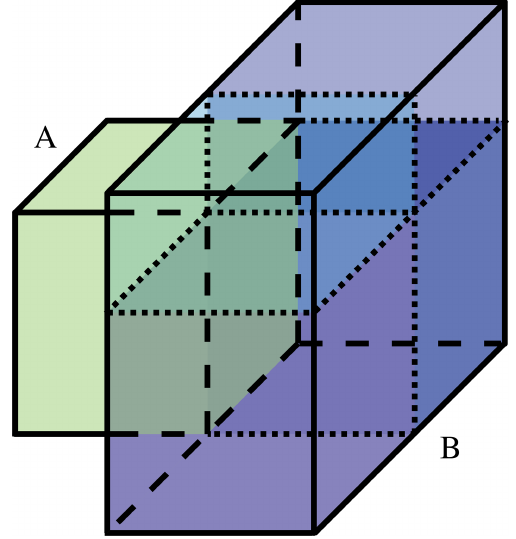
Figure 4. A building consisting of two blocks A and B. Block B will be divided into four smaller blocks, so all faces are either entirely on the inside or outside of the